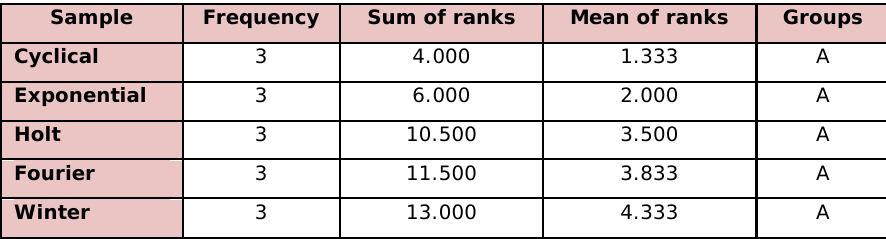
Table 3.”Multiple pair wise for inventory comparisons using the Nemenyi’s procedure”